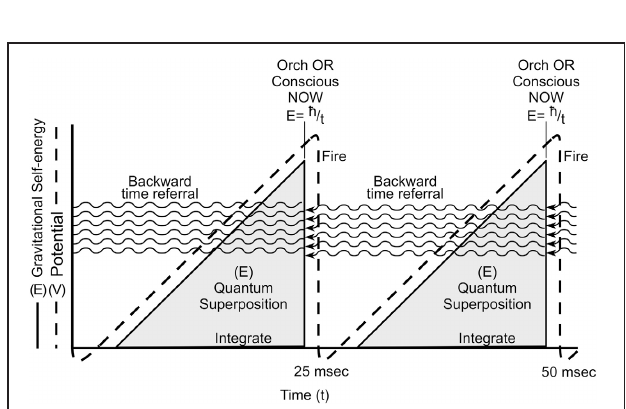
FIGURE 14 | (A) Alignment of aromatic ring structures in tubulins and through microtubule lattice suggests different helical pathways, possible macroscopic “quantum highways” e.g., following the Fibonacci sequence in the A lattice. (B) Top: superpositioned tubulins (gray) increase through first three steps (neuronal integration) until threshold is met by E = ¯ h / t , resulting in Orch OR, a conscious moment, and selection of classical tubulin states which may trigger axonal firing. (B) Bottom: same as (A) , but with topological qubits, i.e., different helical pathways represent information. One particular pathway is selected in the Orch OR conscious moment.